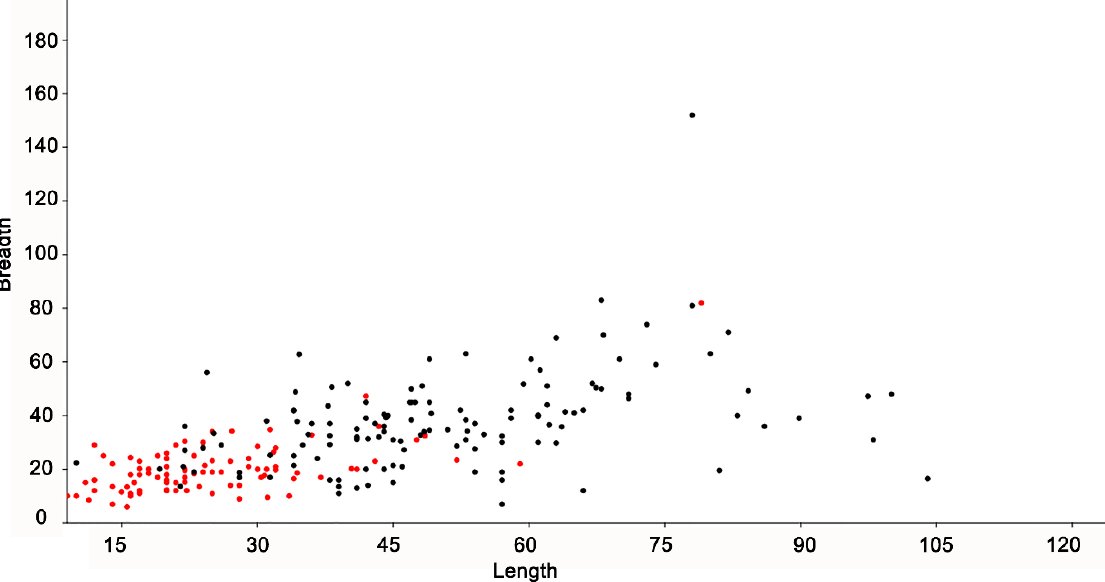
Figure 8. Scatter plot showing quartz (red) and basalt flakes (black) distribution according to their dimensions. Quartz artefacts are clearly smaller in size than basalt implements.